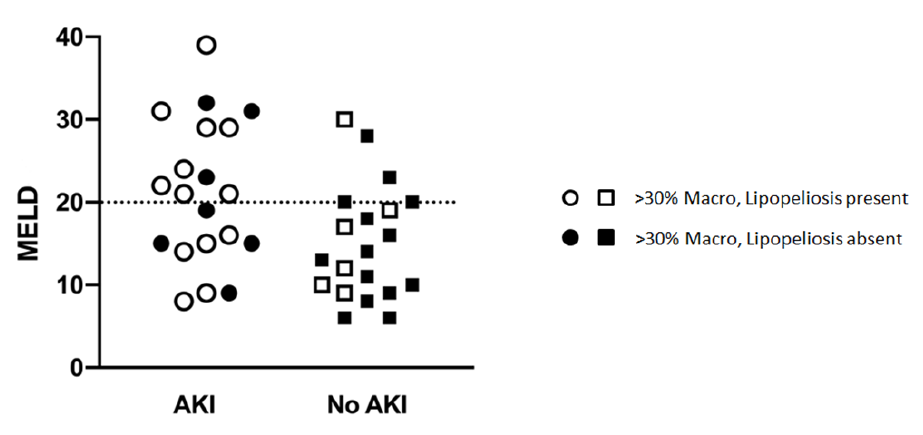
Figure 4. Relationship between MELD, Lipopeliosis and Post-LT AKI. Table 5. Predictors of AKI in Steatotic Grafts—Logistic Regression.